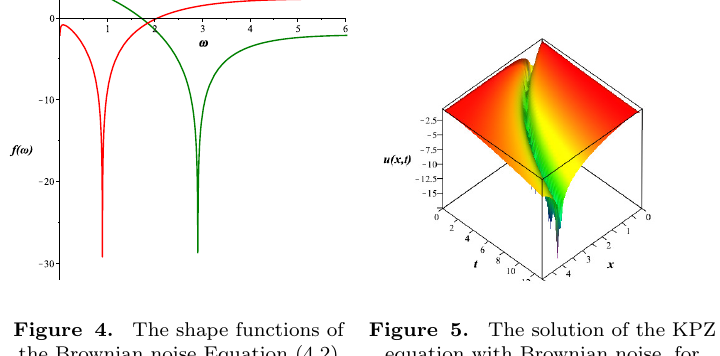
Figure 4. The shape functions of Figure 5. The solution of the KPZ the Brownian noise Equation (4.2) equation with Brownian noise, for for a = λ = 1 , ν = 2 physical the parameter set of parameters. The red line is for λ = ν = c 1 = c 2 = 1 and a = 1 / c 1 = 3 ,c 2 = 1 and and the green line is for the integration constants c 1 = 1 ,c 2 = 3.